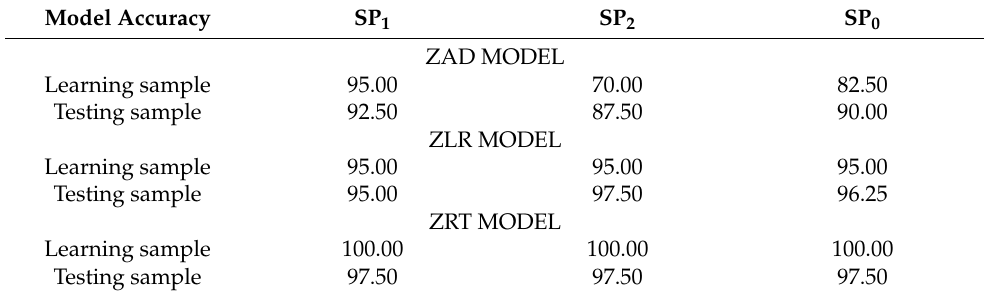
Table 6. Accuracy of Constructed Model